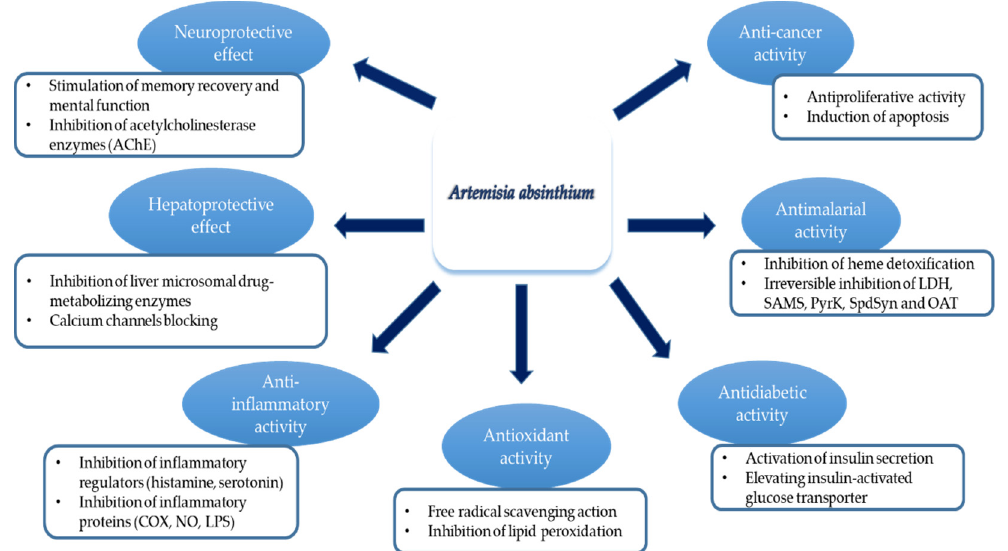
Figure 2. Schematic representation of different pharmacological activities of A. absinthium and their mechanisms . Table 5. The pharmacological activity of A. absinthium related to infectious diseases.